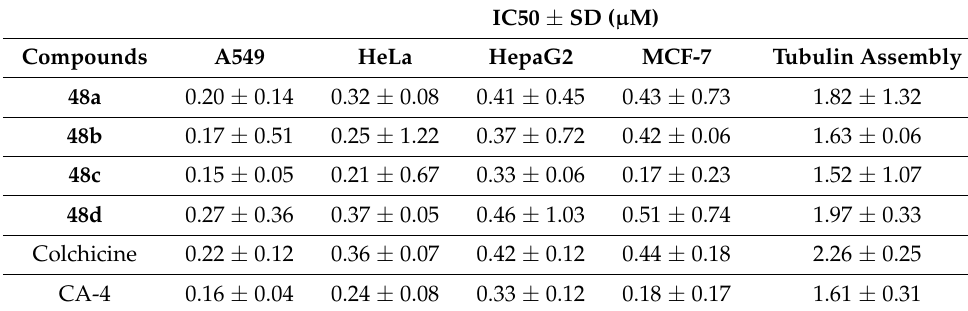
Table 2. Antiproliferative and anti-tubulin activity of compound 48a – d